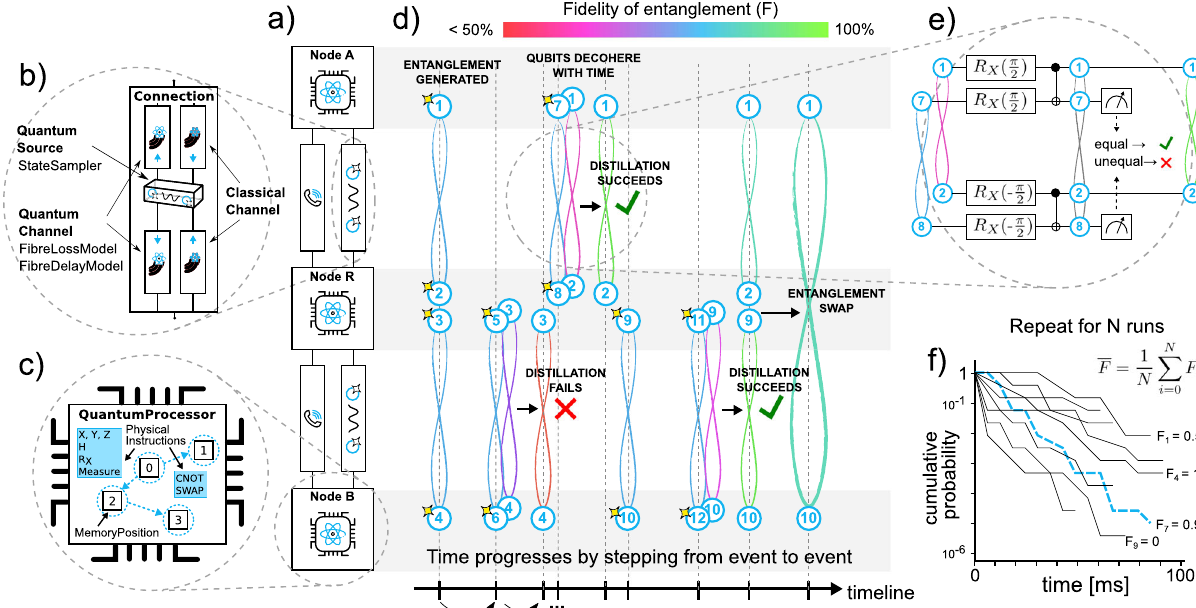
Fig. 1 Illustrative example of a NetSquid use case. Each sub- fi gure explains part of the modelling and simulation process. For greater clarity the fi gures are not based on real simulation data. The scenario shown is a quantum repeater utilising entanglement distillation (see main text). a The setup of a quantum network using node and connection components. b A zoom in showing the subcomponents of the entangling connection component. The quantum channels are characterised using fi bre delay and loss models. The quantum source samples from an entangled bipartite state sampler when externally triggered by the classical channel. c A zoom in of the quantum memory positions within a quantum processor illustrating their physical gate topology. The physical single-qubit instructions possible on each memory in this example are the Pauli ( X , Y , Z ), Hadamard ( H ), and X -rotation ( R X ) gates, and measurement. The blue-dashed arrows show the positions and control direction (where applicable) for which the two-qubit instructions controlled- X (CNOT) and swap are possible. Noise and error models for the memories and gates are also assigned. d Illustration of a single simulation run. Time progresses by discretely stepping from event to event, with new events generated as the simulation proceeds. Qubits are represented by circles, which are numbered according to the order they were generated. A star shows the moment of generation. The curved lines between qubits denote their entanglement with the colour indicating fi delity. The state of each qubit is updated as it is accessed during the simulation, for instance to apply time- dependent noise from waiting in memory. e A zoom in of the distillation protocol. The shared quantum states of the qubits are combined in an entangling step, which then shrinks as two of the qubits are measured. The output is randomly sampled, causing the simulation to choose one of two paths by announcing success or failure. f A plot illustrating the stochastic paths followed by multiple independent simulation runs over time, labelled by their fi nal end-to-end fi delity F i . The blue dashed line corresponds to the run shown in ( d ). The runs are typically executed in parallel. Their results are statistically analysed to produce performance metrics such as the average outcome fi delity and run